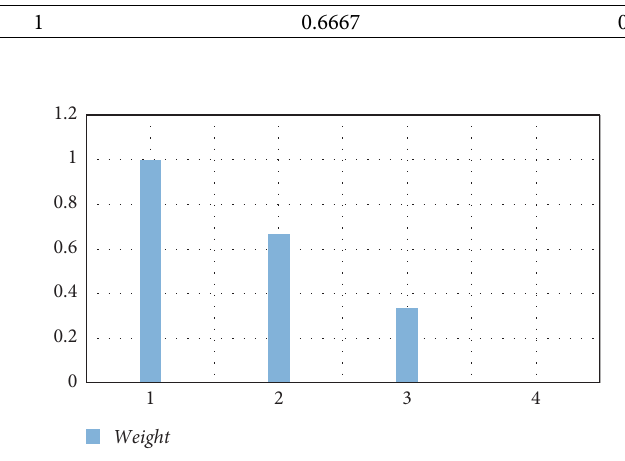
Figure 2: Grade weight of grade I indicators. Table 8: Weights of ideological and moral.